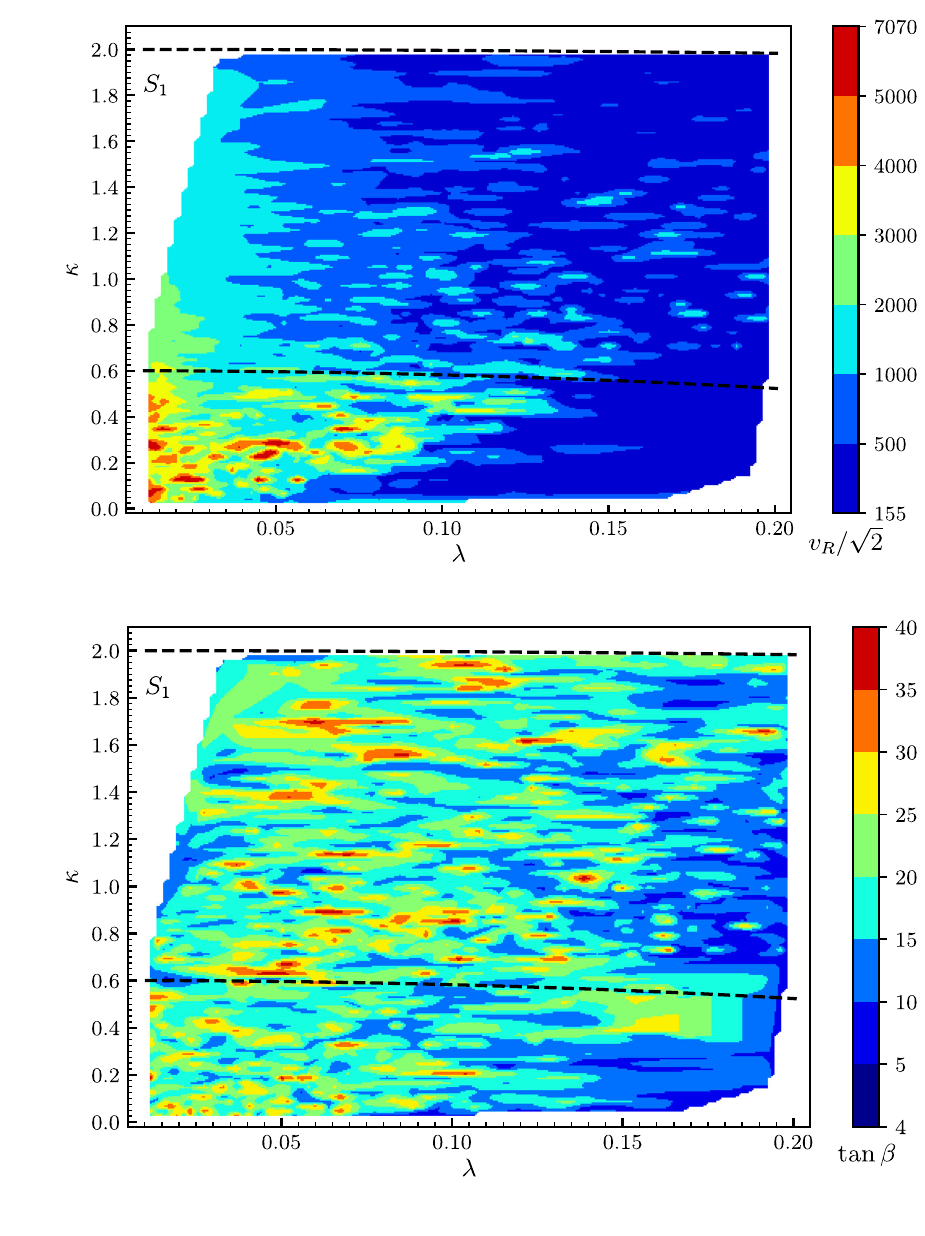
Fig. 16 Viable points of the parameter space for S 1 in the κ − λ plane. The points below the lower black dashed line fulfill the condition of Eq. (25), where perturbativity is assumed up to the GUT scale. All points below the upper dashed line fulfill the condition of Eq. (26), where perturbativity is relaxed up to 10 TeV. The colours